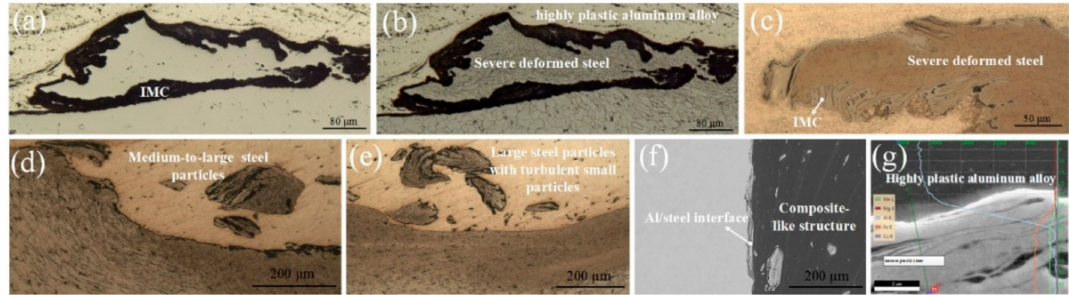
Figure 8. Detailed hook-like structure and composite-like structure of Al/steel lap joint. ( a ) Before corrosion; ( b ) after corrosion; ( c ) reaction between hook-like structure and severe plastic steel; ( d ) the steel particles; ( e , f ) large steel particles with turbulent small particles; and ( g ) IMCs formation at the weld interface.